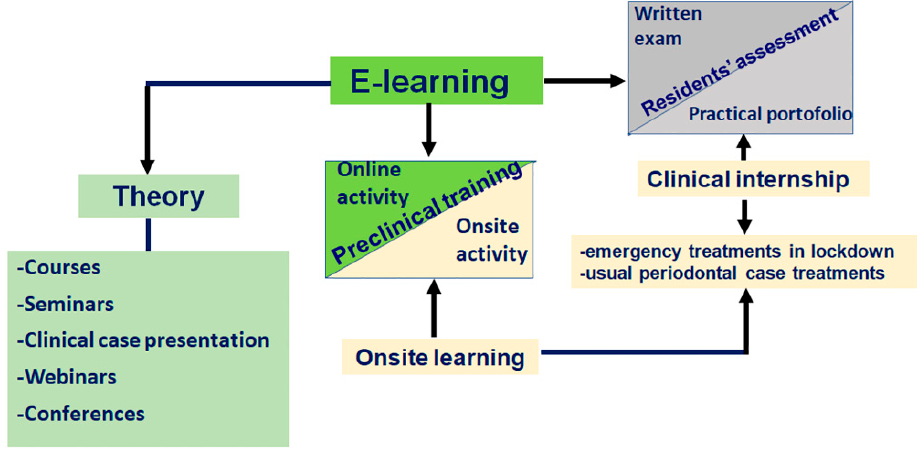
Figure 1. Teaching pillars in the periodontology residency program: adaptation during the COVID-19 crisis.